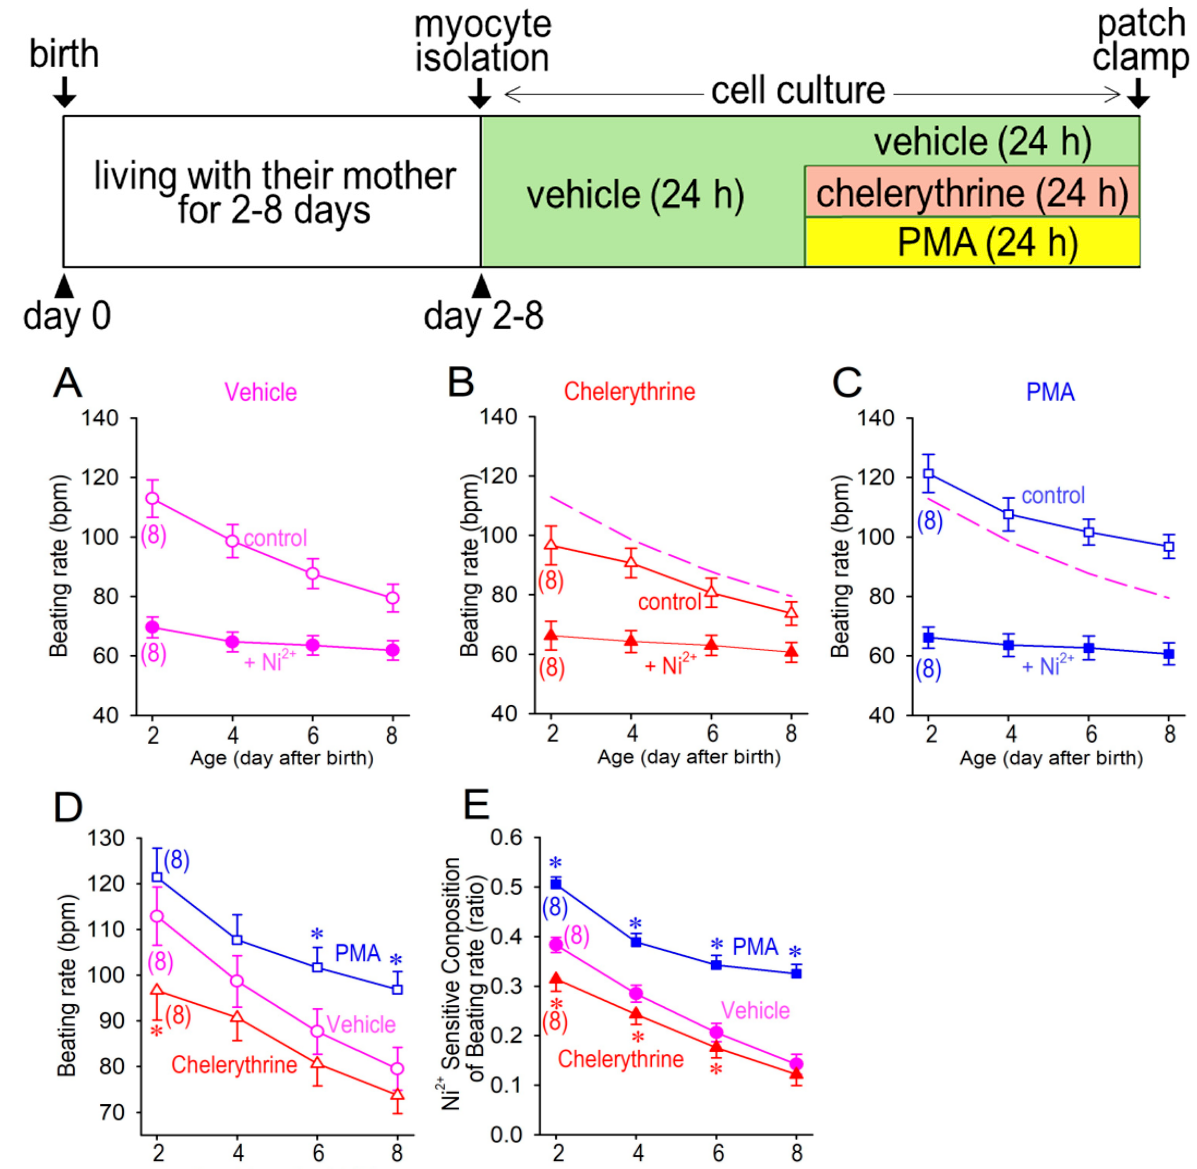
Figure 3. Time-dependent changes of spontaneous beating rates. Myocytes beating rates were plotted against isolation day after birth from day 2 to day 8 treated in vehicle ( A ), with 2 µ M chelerythrine ( B ) and 1 µ M PMA ( C ). Data with 50 µ M Ni 2+ (open symbols) and without Ni 2+ application (filled symbols) are shown in each panel. Magenta dashed lines in panels ( B ) and ( C ) represent data without Ni 2+ (control) in panel ( A ). Changes of beating rates in vehicle, treated with chelerythrine, and PMA without Ni 2+ application (control) in panels A, B, and C are compared in panel ( D ). Components of Ni 2+ -sensitive beating rates are plotted as a ratio to those without Ni 2+ ( E ). Actions of Ni 2+ were assessed 5 min after application to the bath solution. Note that chelerythrine and PMA were washed out in the culture medium prior to the electrophysiological study. Data were expressed as mean ± S.D. ( n = 8). * p < 0.05, compared with those in vehicle at the same age. Protocols for myocytes isolation and cell culture are shown in the inset above.